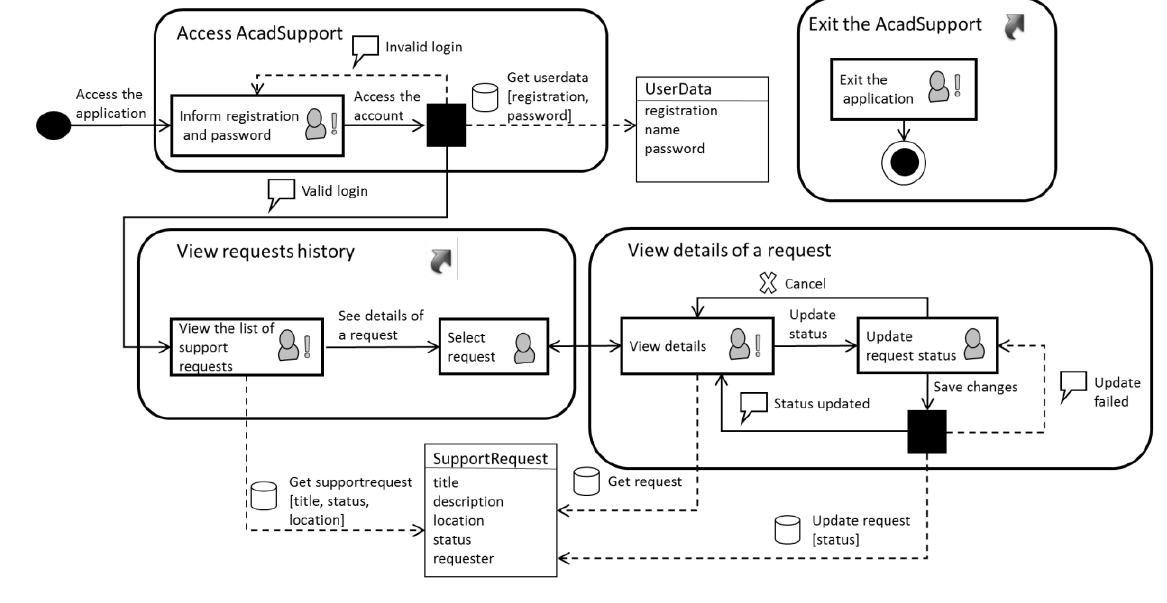
Fig 2. Example of a USINN diagram.